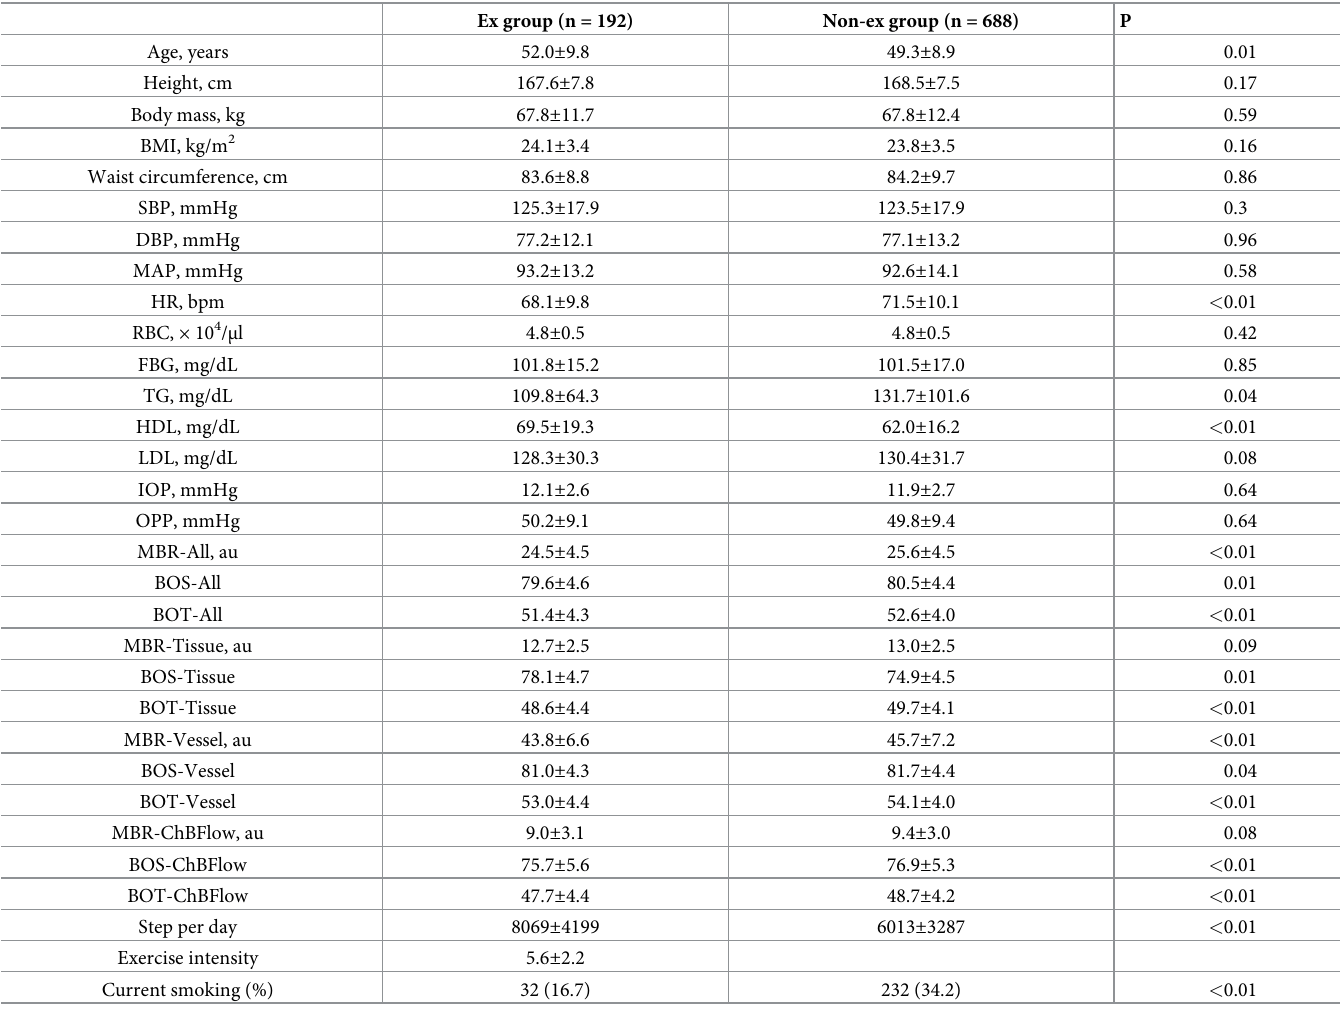
Table 3. Characteristics categorized by the MHLW-based Ex and Non-ex